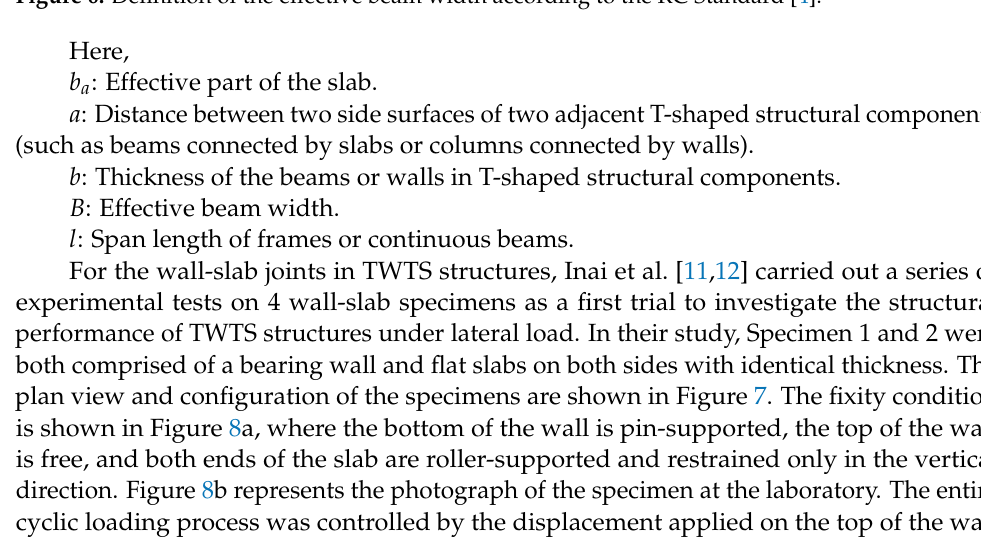
Figure 6. Definition of the effective beam width according to the RC Standard